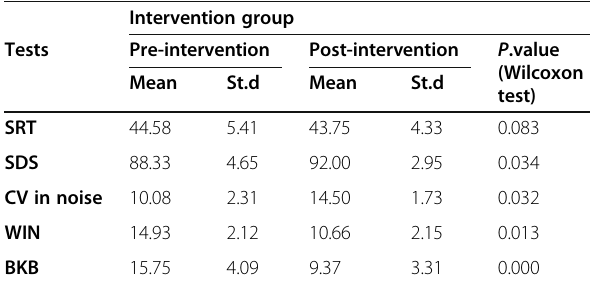
Table 3 Wilcoxon test was used to compare the pre- and post- intervention results in the intervention